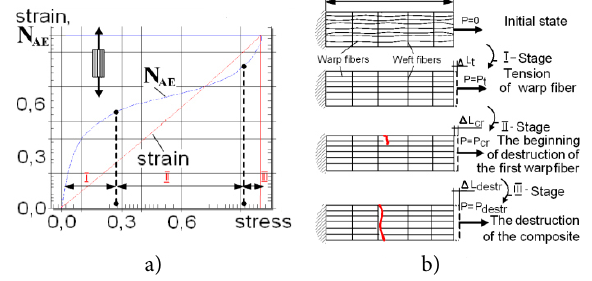
a) b) Fig. 7. Graph of the total AE change and the deformation due to the stress-strain (a) and the assumed mechanism for the destruction of the composite in the longitudinal arrangement of base fibers with respect to the tensile force (b)